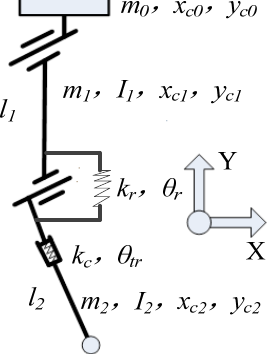
Figure 5. Simplified mechanism with buffer parts.